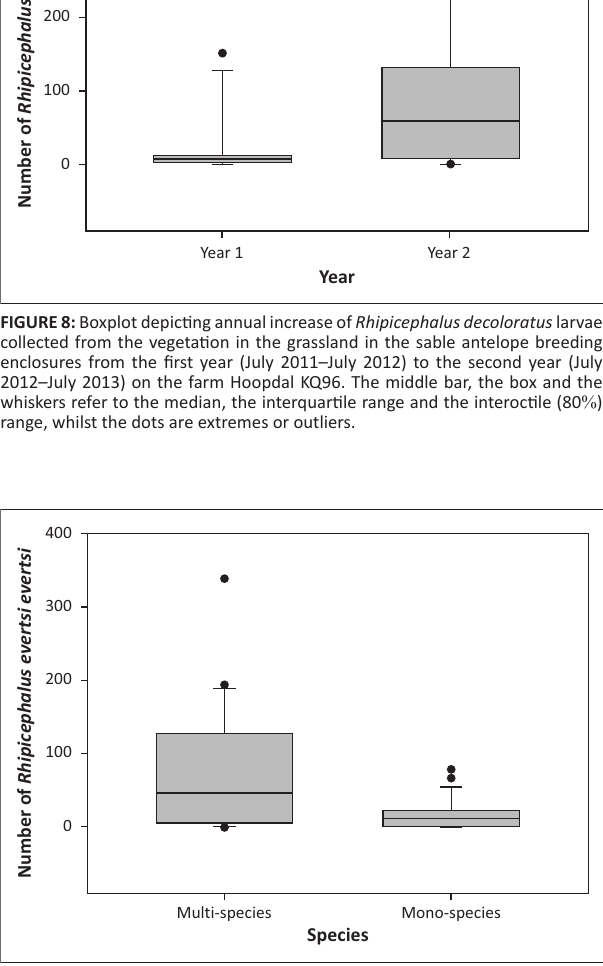
FIGURE 9: Boxplot depicting the number of Rhipicephalus evertsi evertsi larvae collected in grassland in the multi-species enclosure versus the sable antelope breeding enclosures on the farm Hoopdal KQ96. The middle bar, the box and the whiskers refer to the median, the interquartile range and the interoctile (80 % ) range, whilst the dots are extremes or